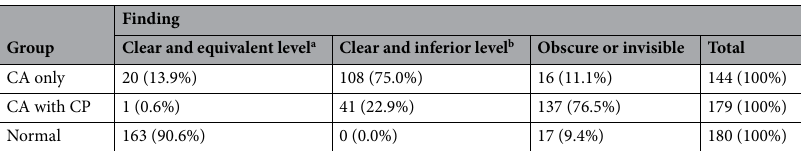
Table 2. Findings on the inferior line of the piriform aperture (number of images). a The inferior line of the piriform aperture could be observed clearly on the both right and left sides at an equivalent level. b The inferior line of the piriform aperture on the affected side was clearly visible but located at an inferior level relative to the unaffected side, or the line on a side was located at an inferior level relative to the contralateral side in normal subjects.